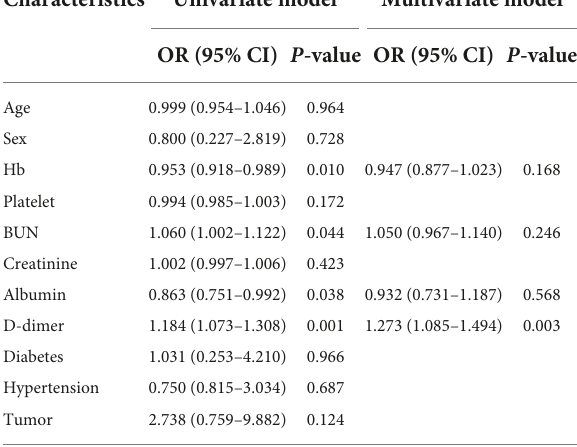
TABLE 3 Factors affecting in-hospital outcomes in AUGIB patients with myocardial injury. Characteristics Univariate model Multivariate